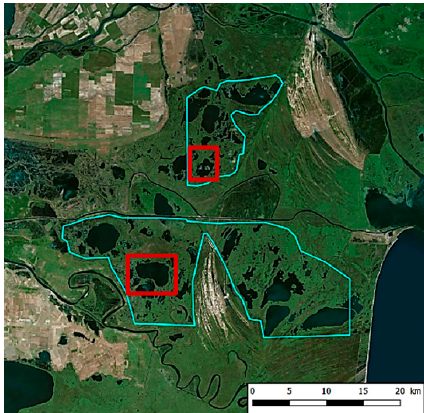
Figure 10. Macrophyte classifications for the southern zone. ( a ) Classification of the S2 stack (bands and indices; 04 / 28 / 2016) in detailed nomenclature. ( b ) Classification of the S2 stack (bands and indices; 08 / 16 / 2016) in simple nomenclature.